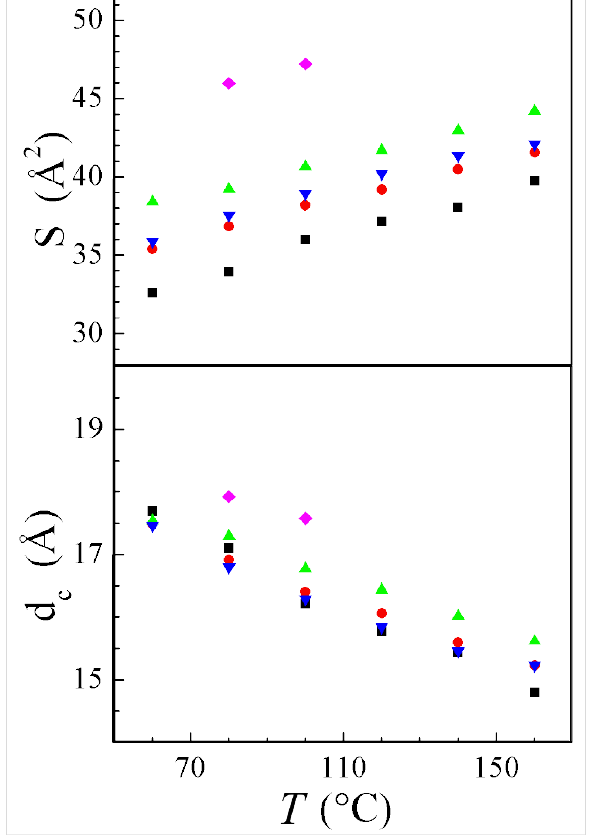
Figure 7: Variation with the counter-ion of the molecular area S and of the ionic sublayer thickness d c (including mesogenic segments) in the smectic A phase for series: squares: 1 14 ; circles: 2 14 ; up triangles: 3 14 ; down triangles: 4 14 ; diamonds: 5 14